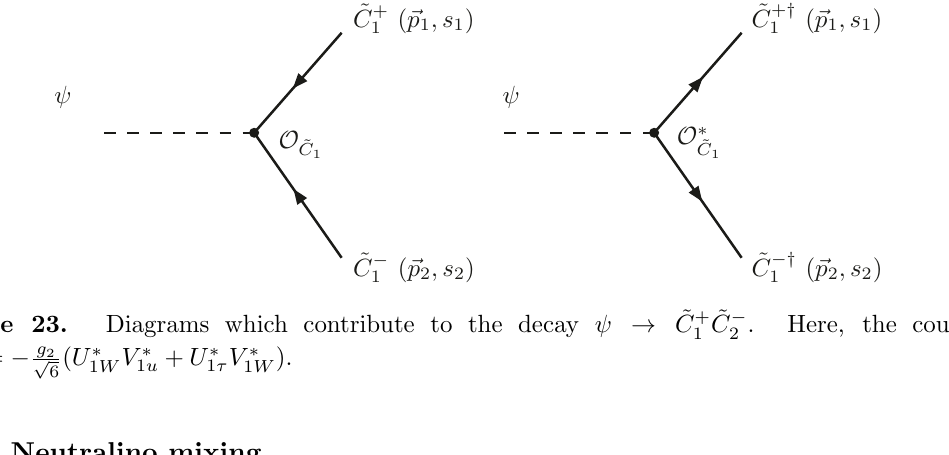
Figure 23. Diagrams which contribute to the decay ! ~ C +